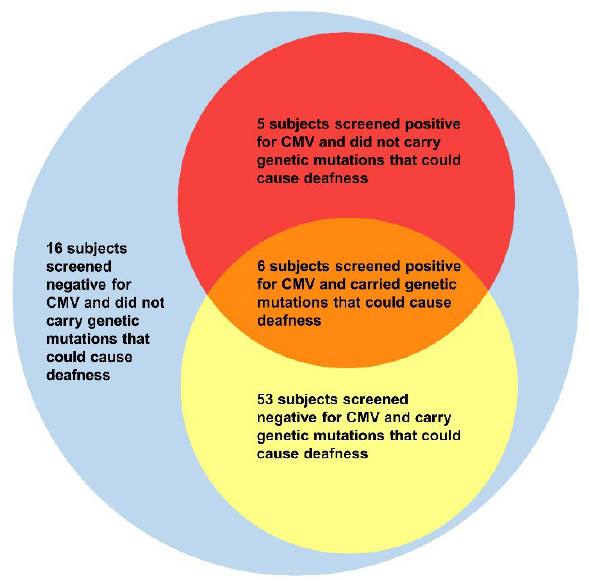
Figure 1. Graph of CMV screening and next-generation sequencing results .